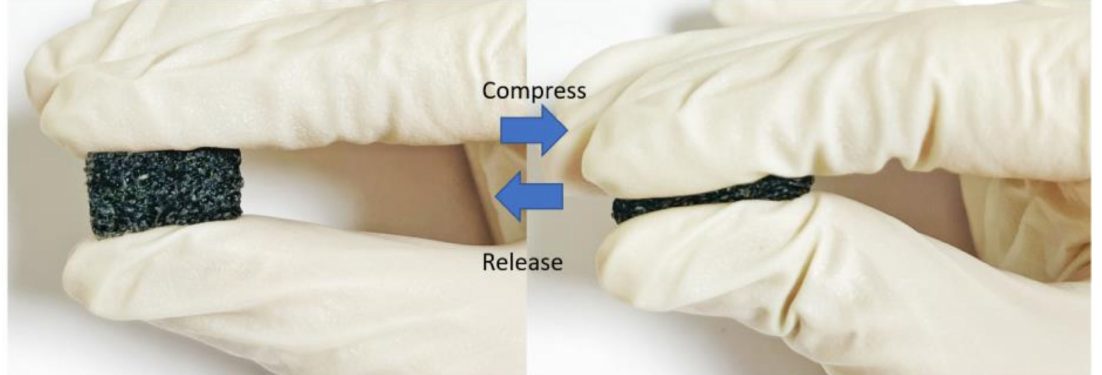
Figure 11. High flexibility of the dielectric